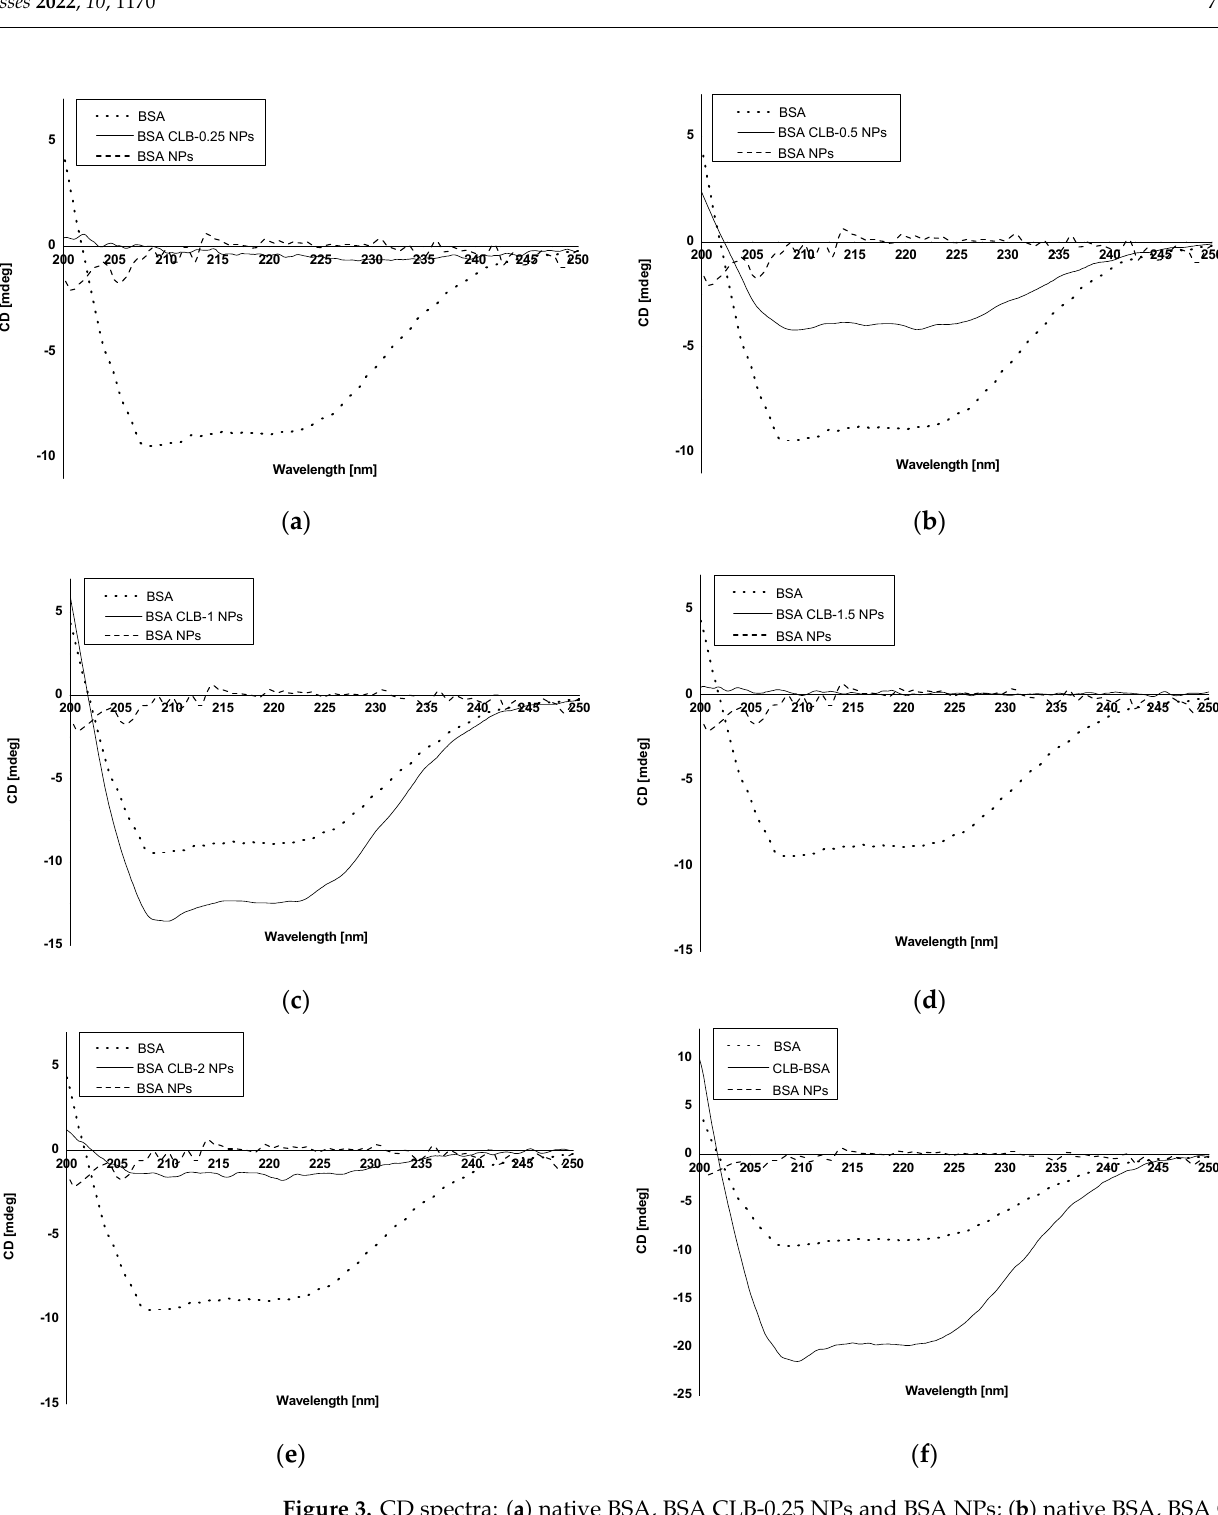
Table 4. The mean residue ellipticity ( Θ MRW ).